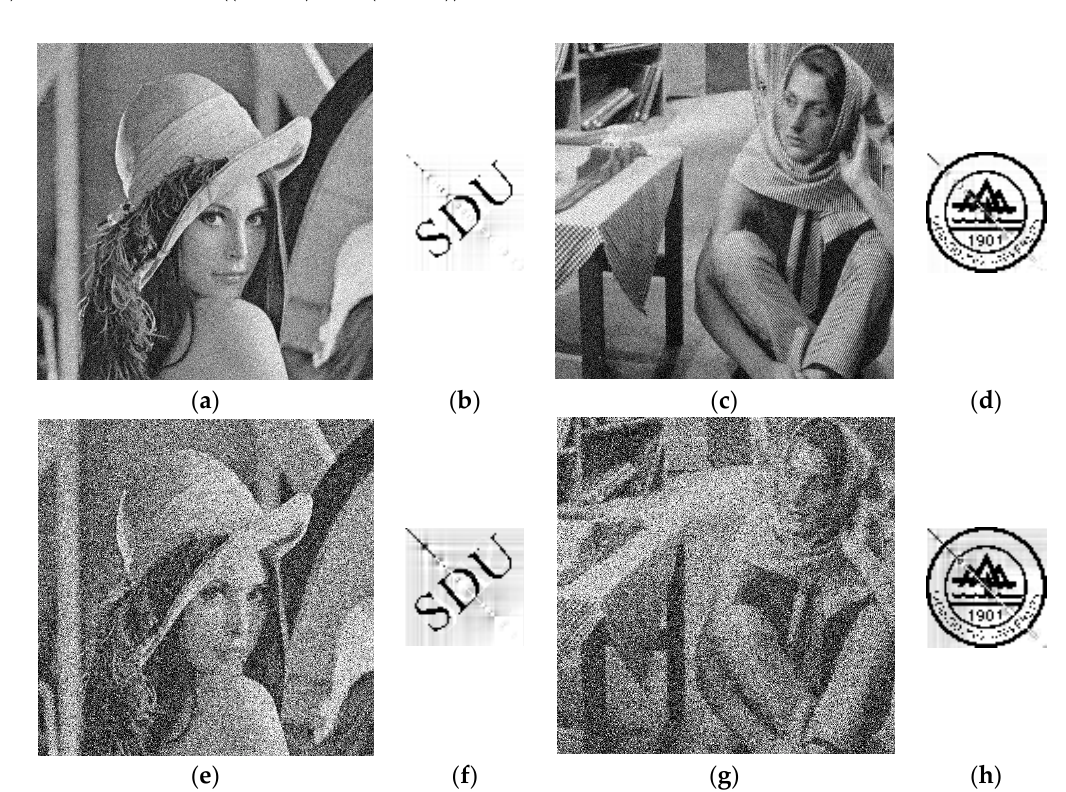
Figure 13. Watermarked images and extracted watermarks under Gaussian noise: ( a ) watermarked Lena under Gaussian noise (0, 0.01); ( b ) extracted watermark w 1 ; ( c ) watermarked Barbara under Gaussian noise (0, 0.01); ( d ) extracted watermark w 2 ; ( e ) watermarked Lena under Gaussian noise (0, 0.05); ( f ) extracted watermark w 1 ; ( g ) watermarked Barbara under Gaussian noise (0, 0.05); ( h ) extracted watermark w 2 . (4) Center cropping (25%).